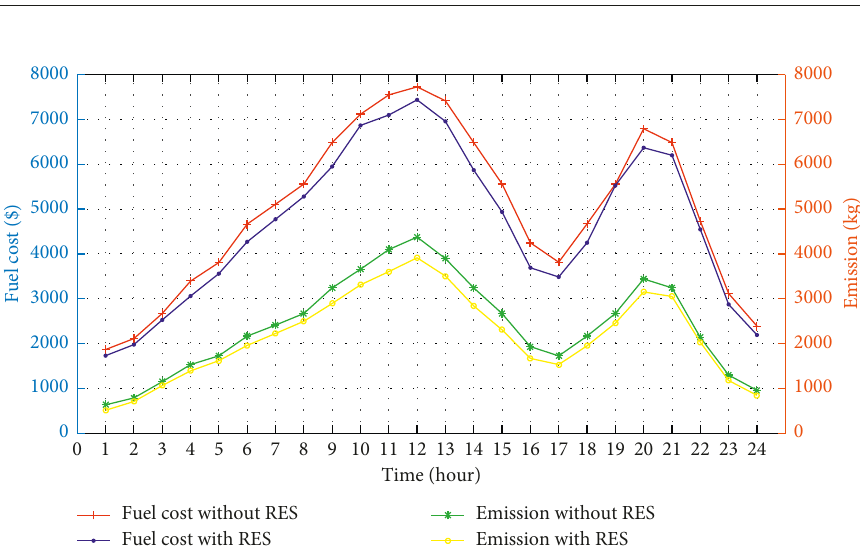
Figure 5: The impact of PV and wind power generation on cost and Table 11: Comparison with MODE and NSGA-II.